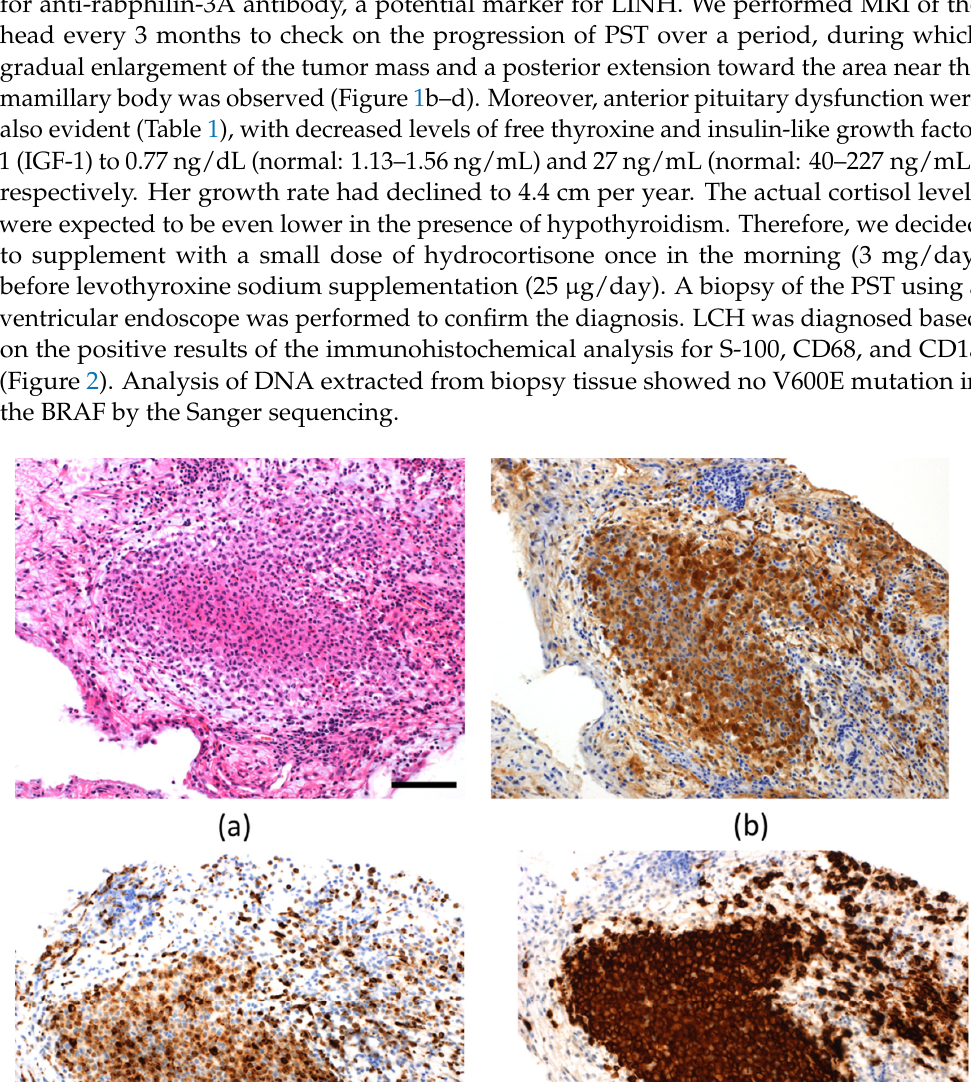
Table 1. The results of the anterior pituitary stimulation tests.